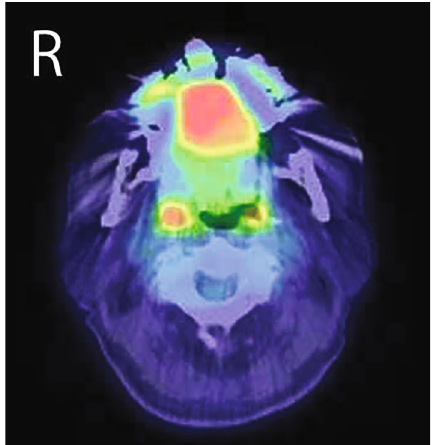
Figure 3: Positron emission tomography/computed tomography showing abnormal accumulation of fl uorodeoxyglucose in the oral mass (maximum standardized uptake value 7.2).